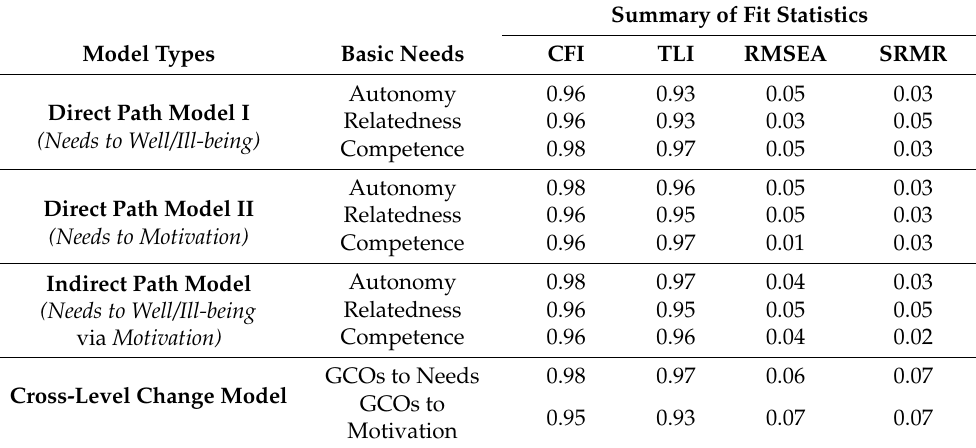
Table 9. Summary of LGM Models Fit